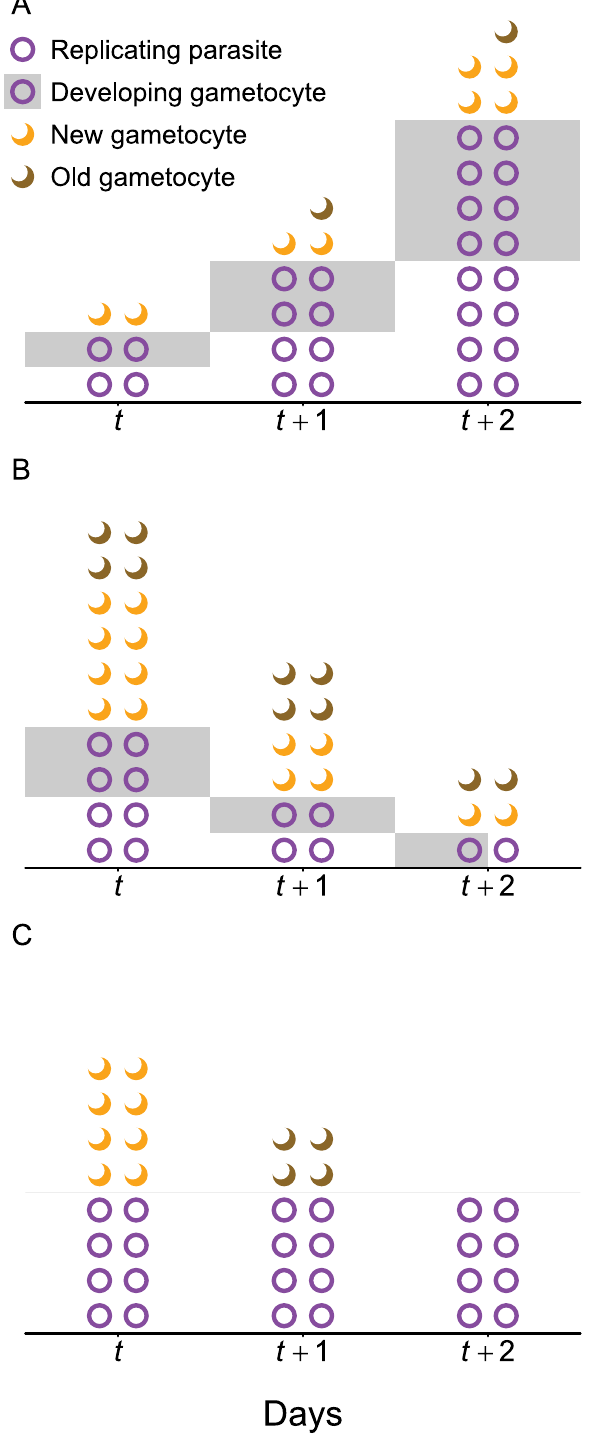
Fig 1. Gametocyte numbers can increase (A) or decrease (B, C) even when transmission investment is constant over the time period observed. For clarity, we assume that replication and gametocyte development both require one day and 50% of new gametocytes persist for an additional day ( “ Old gametocytes ” ). (A) Gametocyte numbers may increase because the parasite population is expanding, even though the percentage of each cohort committed to transmission remains 50%. That is, parasites in half of